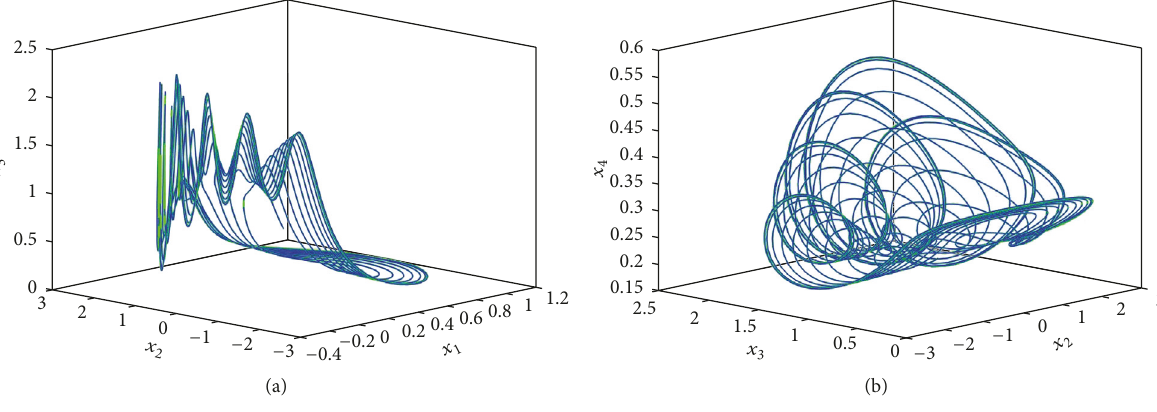
Figure 1: 3D phase portraits of the smart grid system